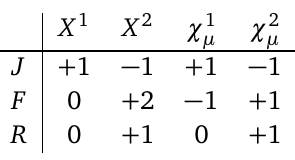
Table 1: Weights of hypermultiplet fields in the B